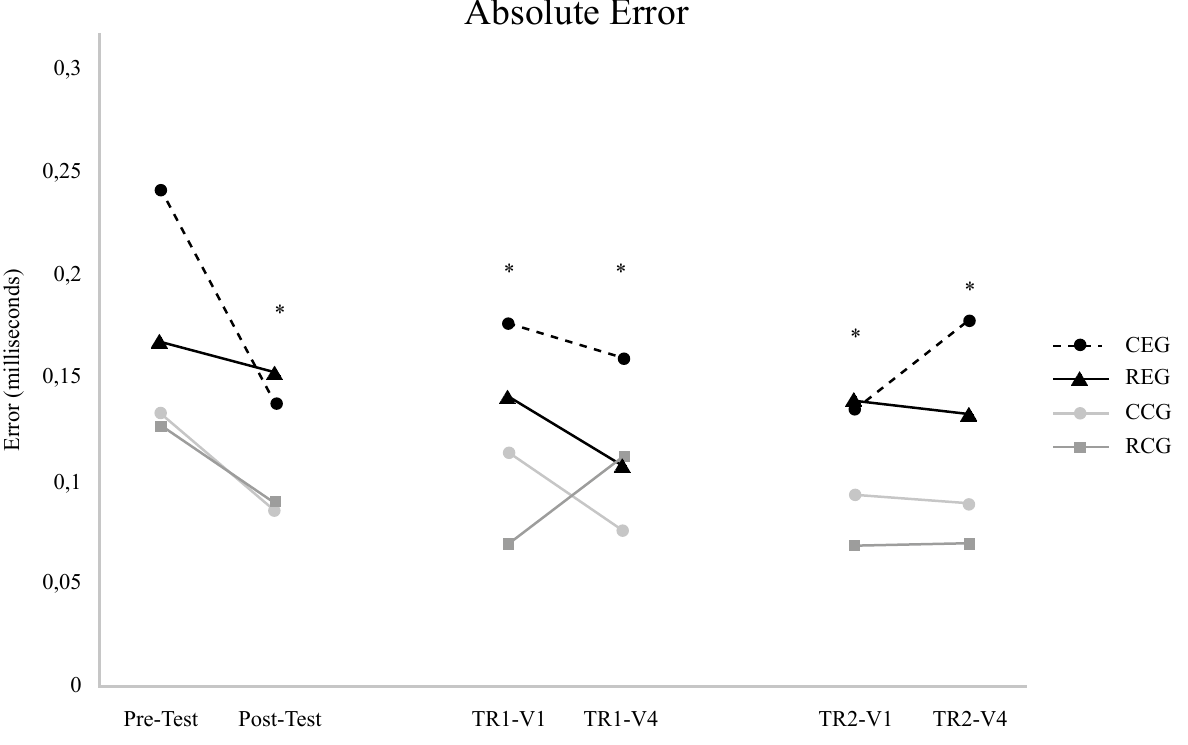
Figure 1= Mean of the absolute error along blocks of trials for all groups. Legend: CEG – Constant Experimental Group, REG – Random Experi - mental Group, CCG – Constant Control Group, RCG – Random Control Group, TR1 – Immediate Transfer Test, TR2 – Long Term Transfer Test,